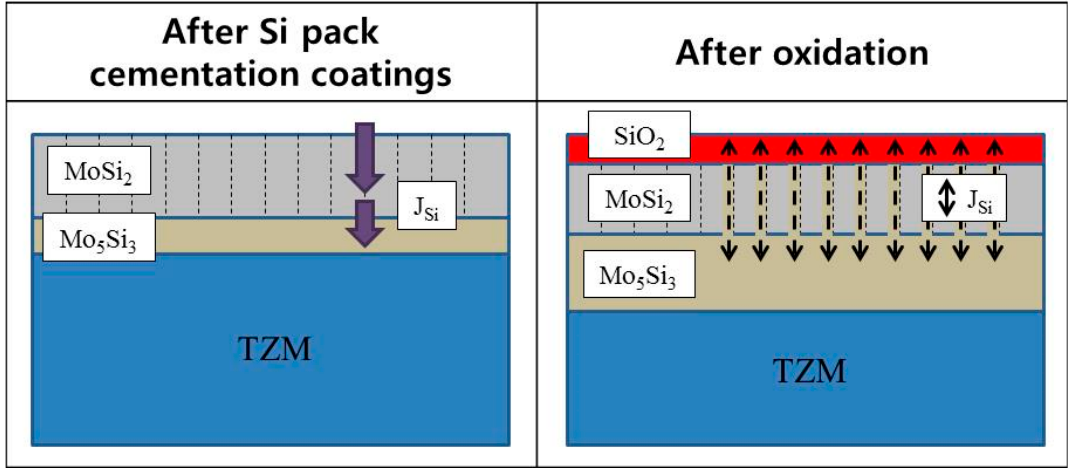
Figure 9. Schematic illustration of MoSi 2 coatings and the formation of Mo 5 Si 3 phase inside the MoSi 2 layer after oxidation.